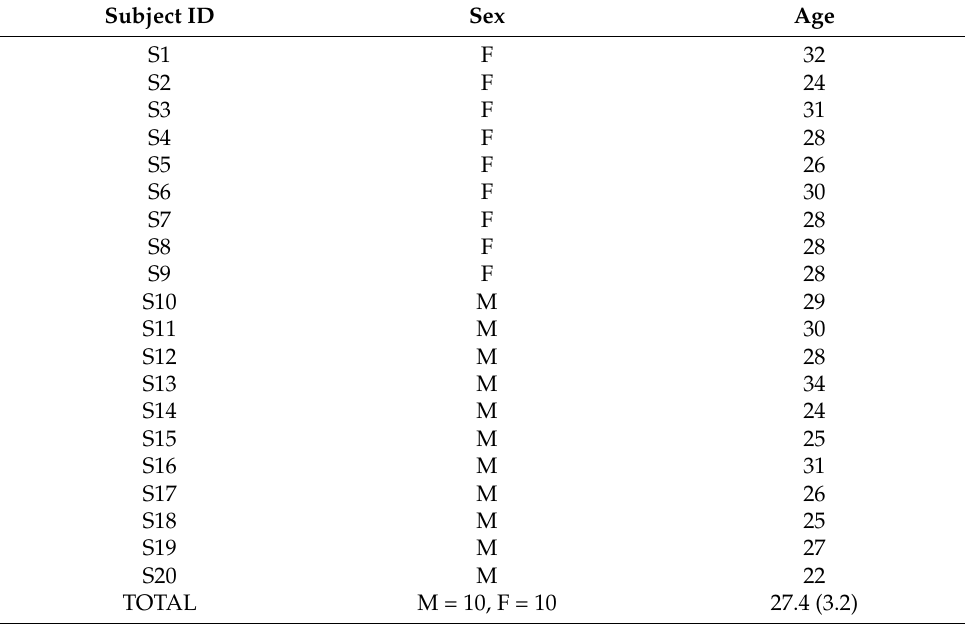
Table 1. Description of subject participating in this study.